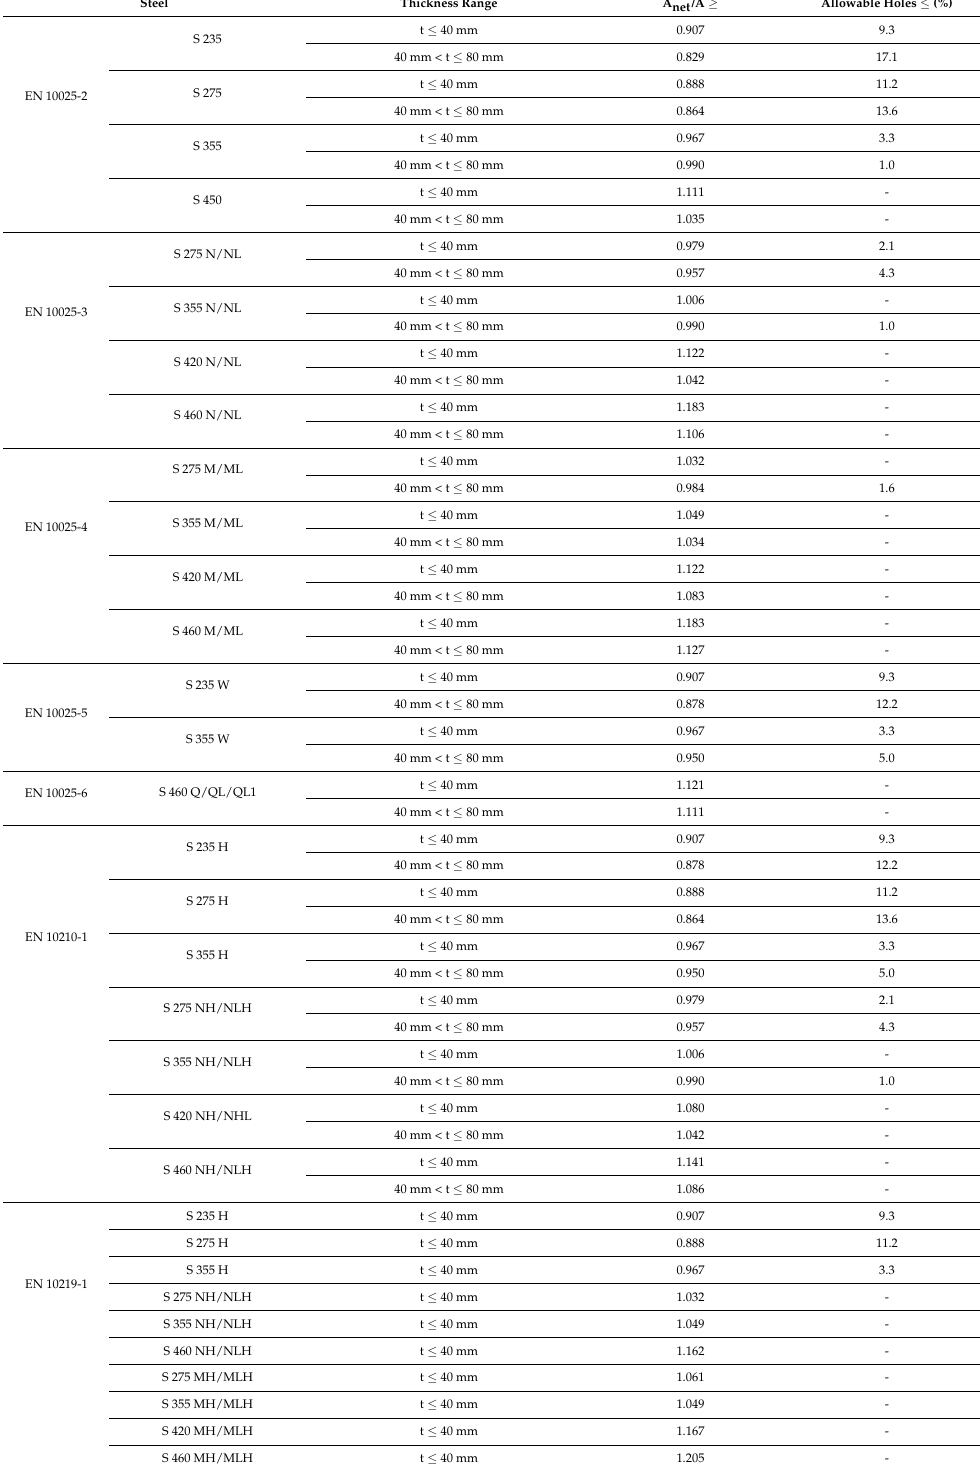
Table 3. Allowable net/gross area ratio for bolted steel connections under the Eurocode 8 framework, considering EN1993-1-1 steel